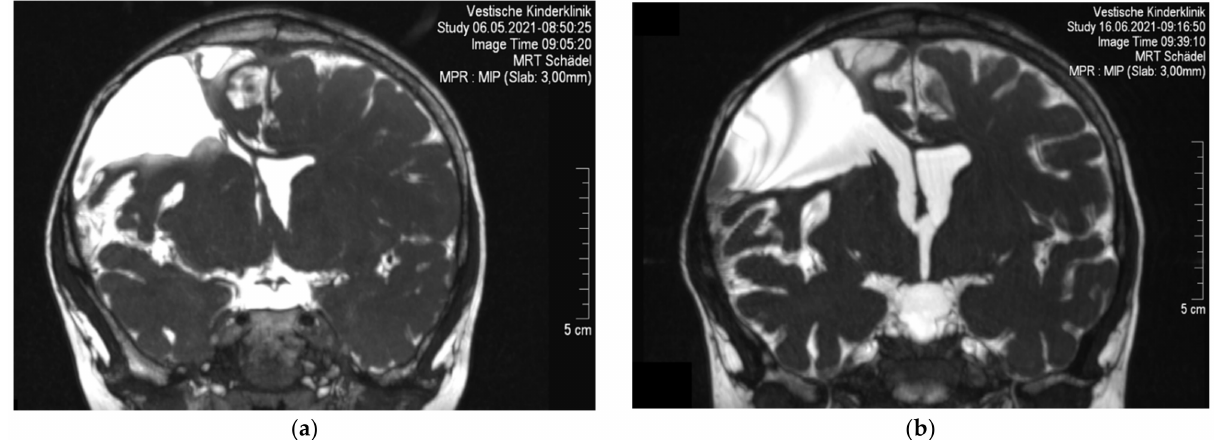
Figure 2. ( a ) T2-weighted CISS MRI sequence in coronal plane before disconnection of the VP shunt. Significant loss of volume of the lateral ventricles, with noticeable rightward distortion of the septum pellucidum and a craniocaudal diameter of the right lateral ventricular anterior horn of 2 mm as a sign of overdrainage. Right fronto-parietal appears a wedge-shaped lesion secondary to the ganglioglioma resection. ( b ) T2-weighted CISS MRI sequence in coronal plane after disconnection of the VP shunt. It shows unfolding of the ventricular system and medialization of the septum pellucidum with a widening of the anterior horn of the right lateral ventricle to 11 mm. The wedge-shaped lesion right fronto-parietal communicates with the right lateral